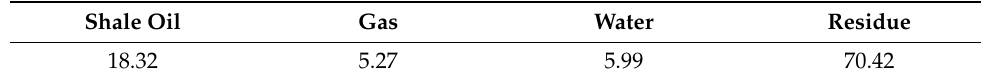
Table 2. Fischer assay analysis (wt. %).